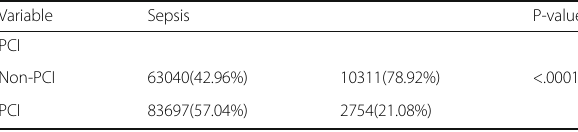
Table 62 (abstract A188). Characteristics in patients with/without sepsis-3